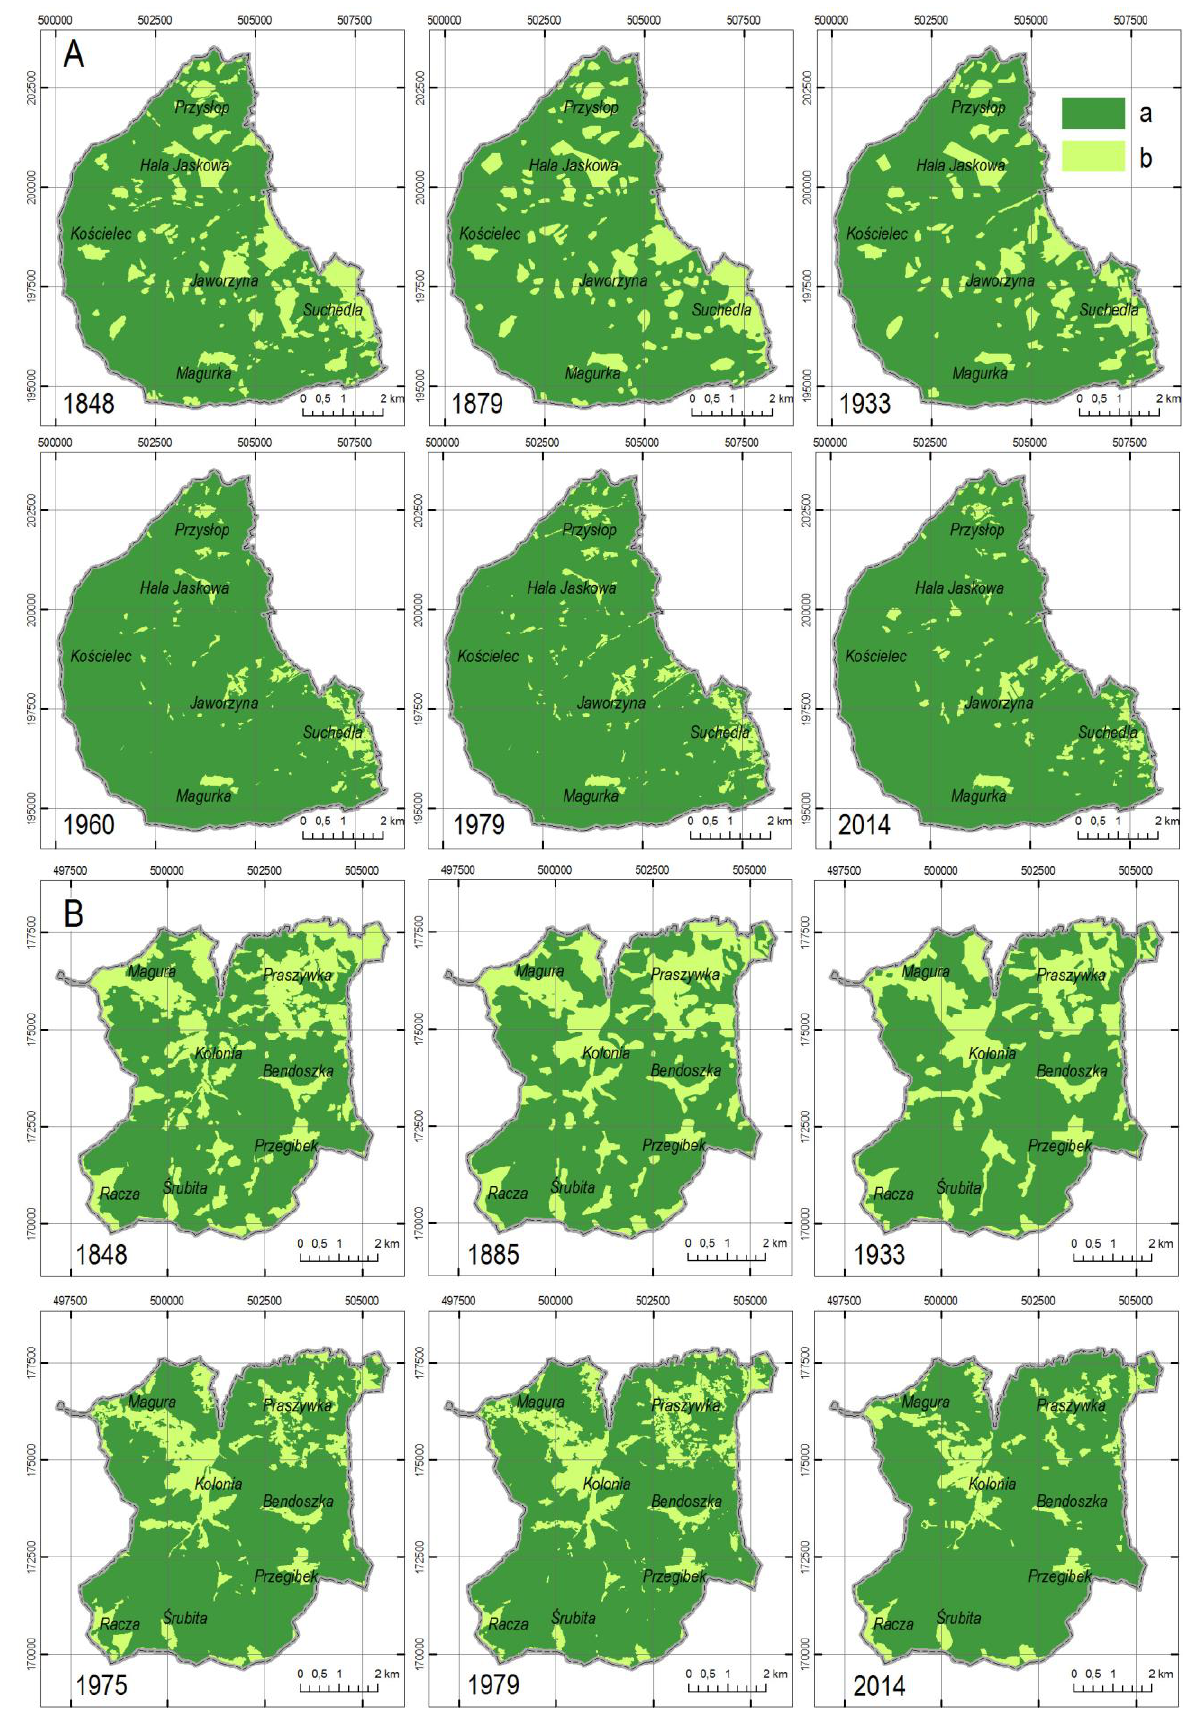
Fig. 2. Land cover changes between 1848-2014: A – the Wiślańskie mountain range, B – the Raczańskie mountain range (source: author’s own elaboration based on cartographic materials mentioned in the text) a – forests, b – non-forested